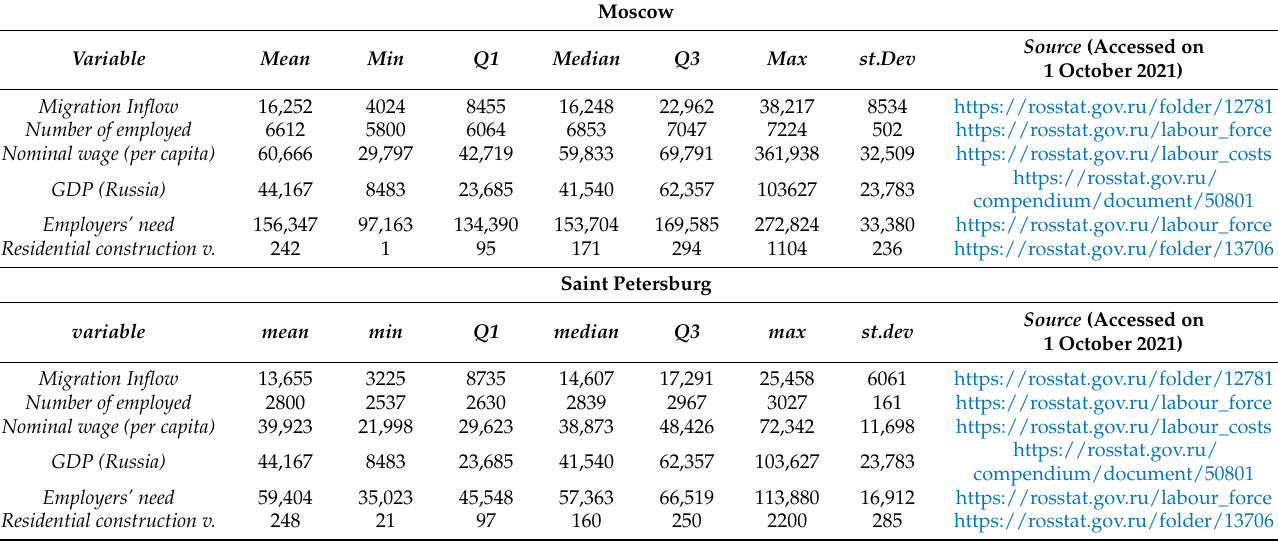
Table 1. Descriptive statistics of the migration data and the macroeconomic